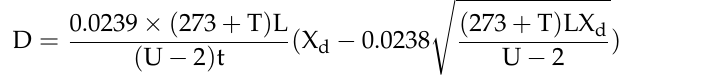
Figure 2. Capillary water absorption test device figure.